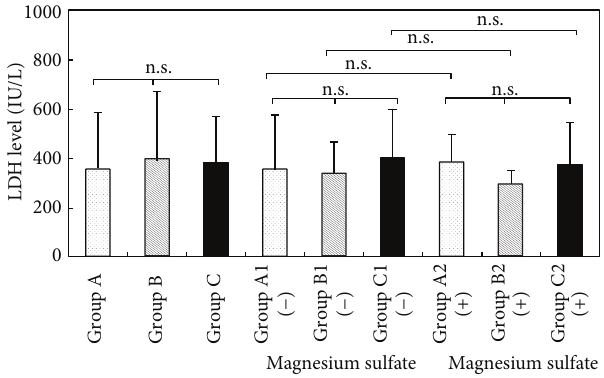
Figure 2: LDH levels in umbilical blood after tocolysis.